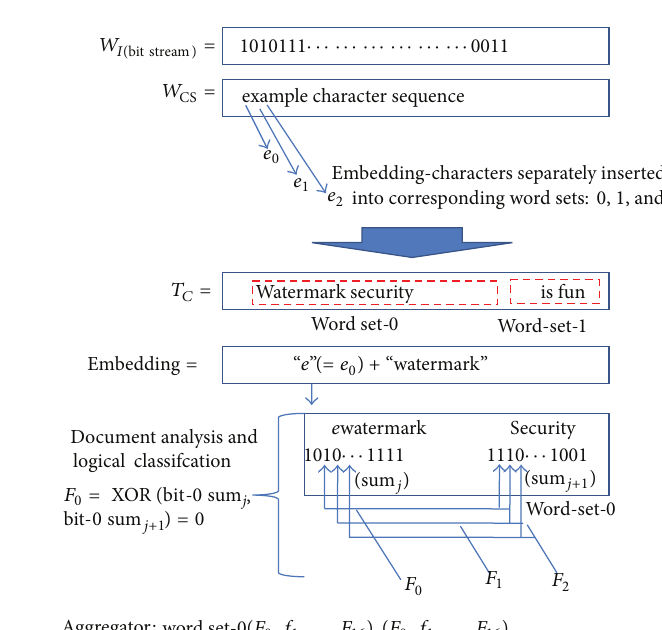
Figure 4: Watermark encoding process.